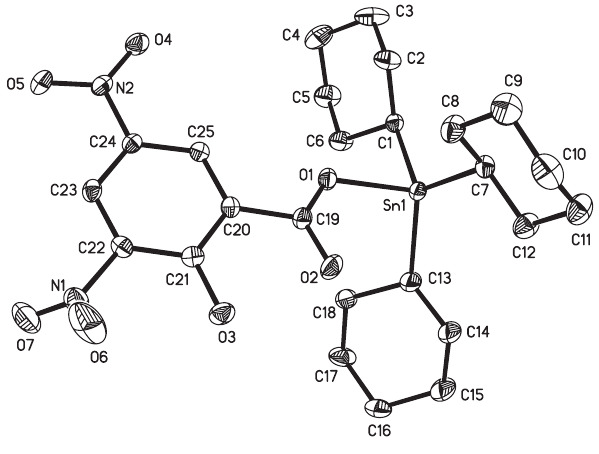
Figure 3: The molecular structure of 3 . Hydrogen atoms are omitted for clarity.